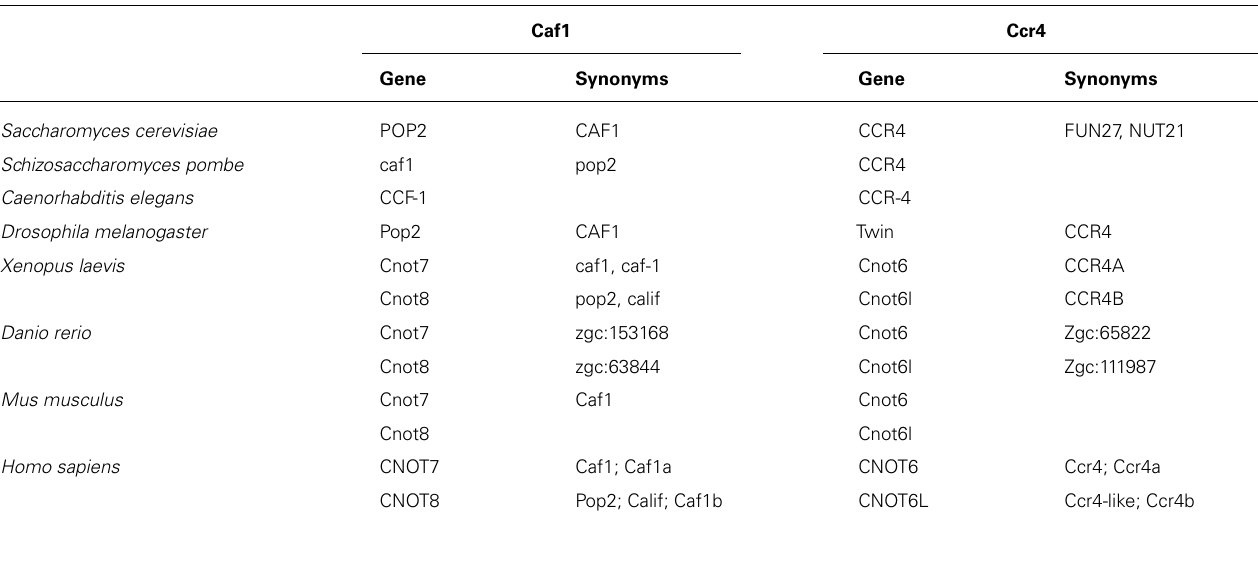
Table 1 | Standard names and synonyms of the Ccr4-Not nuclease